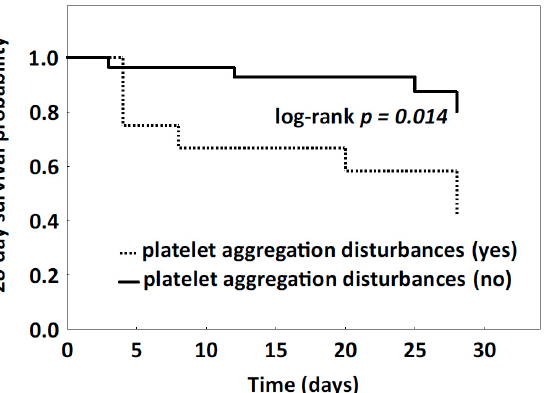
Figure 3. Probability of 28-day survival (Kaplan–Meier curve, log-rank test). Patients with platelet aggregation disturbances on the first day of ICU treatment are indicated by a dotted line and patients without aggregation disturbances by a solid line.